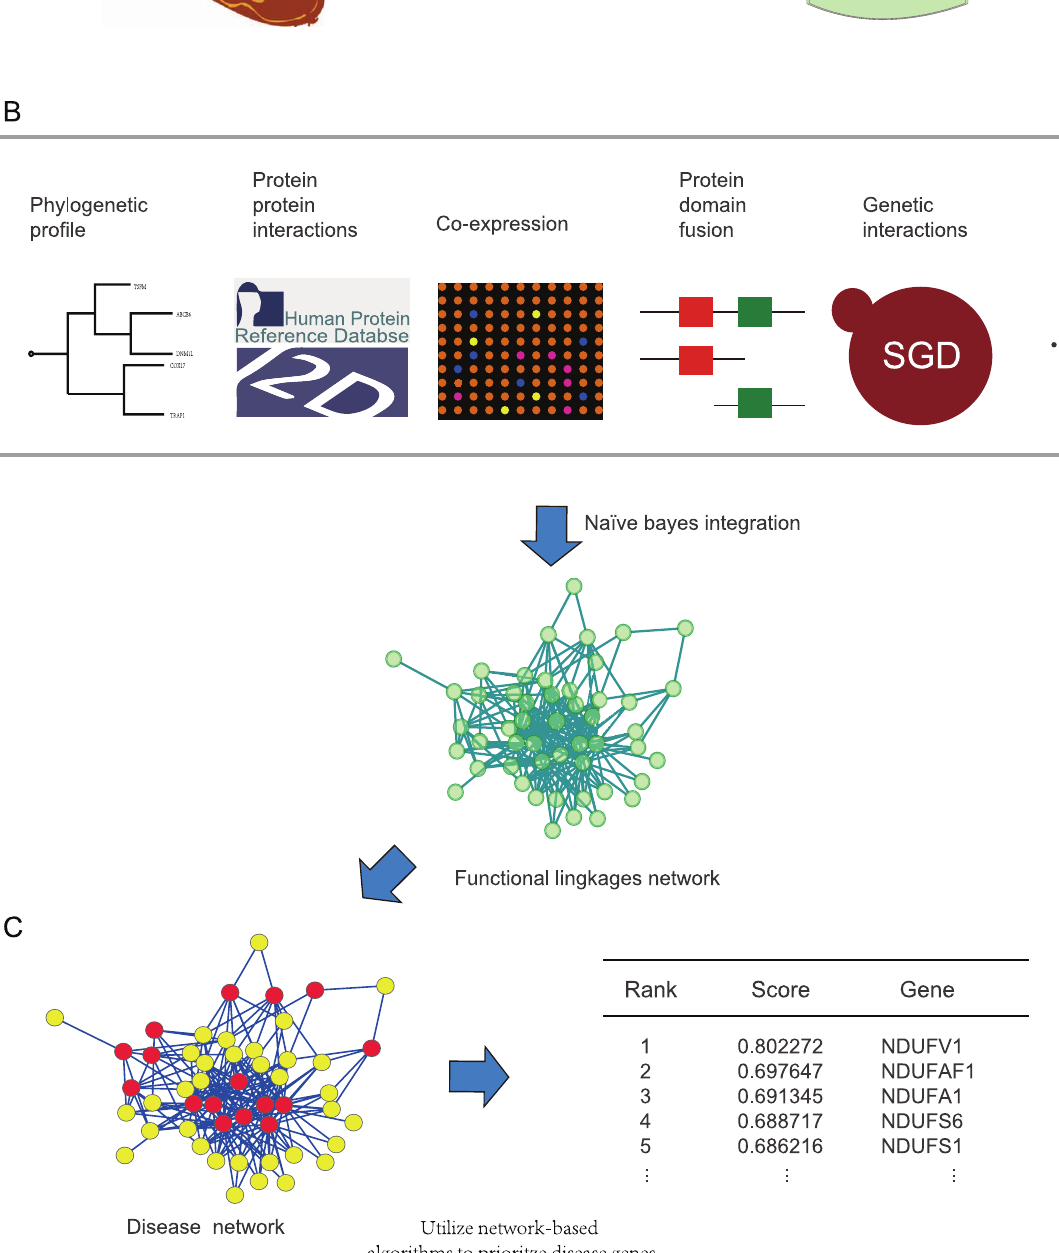
PLOS ONE | www.plosone.org 3 October 2014 | Volume 9 | Issue 10 |